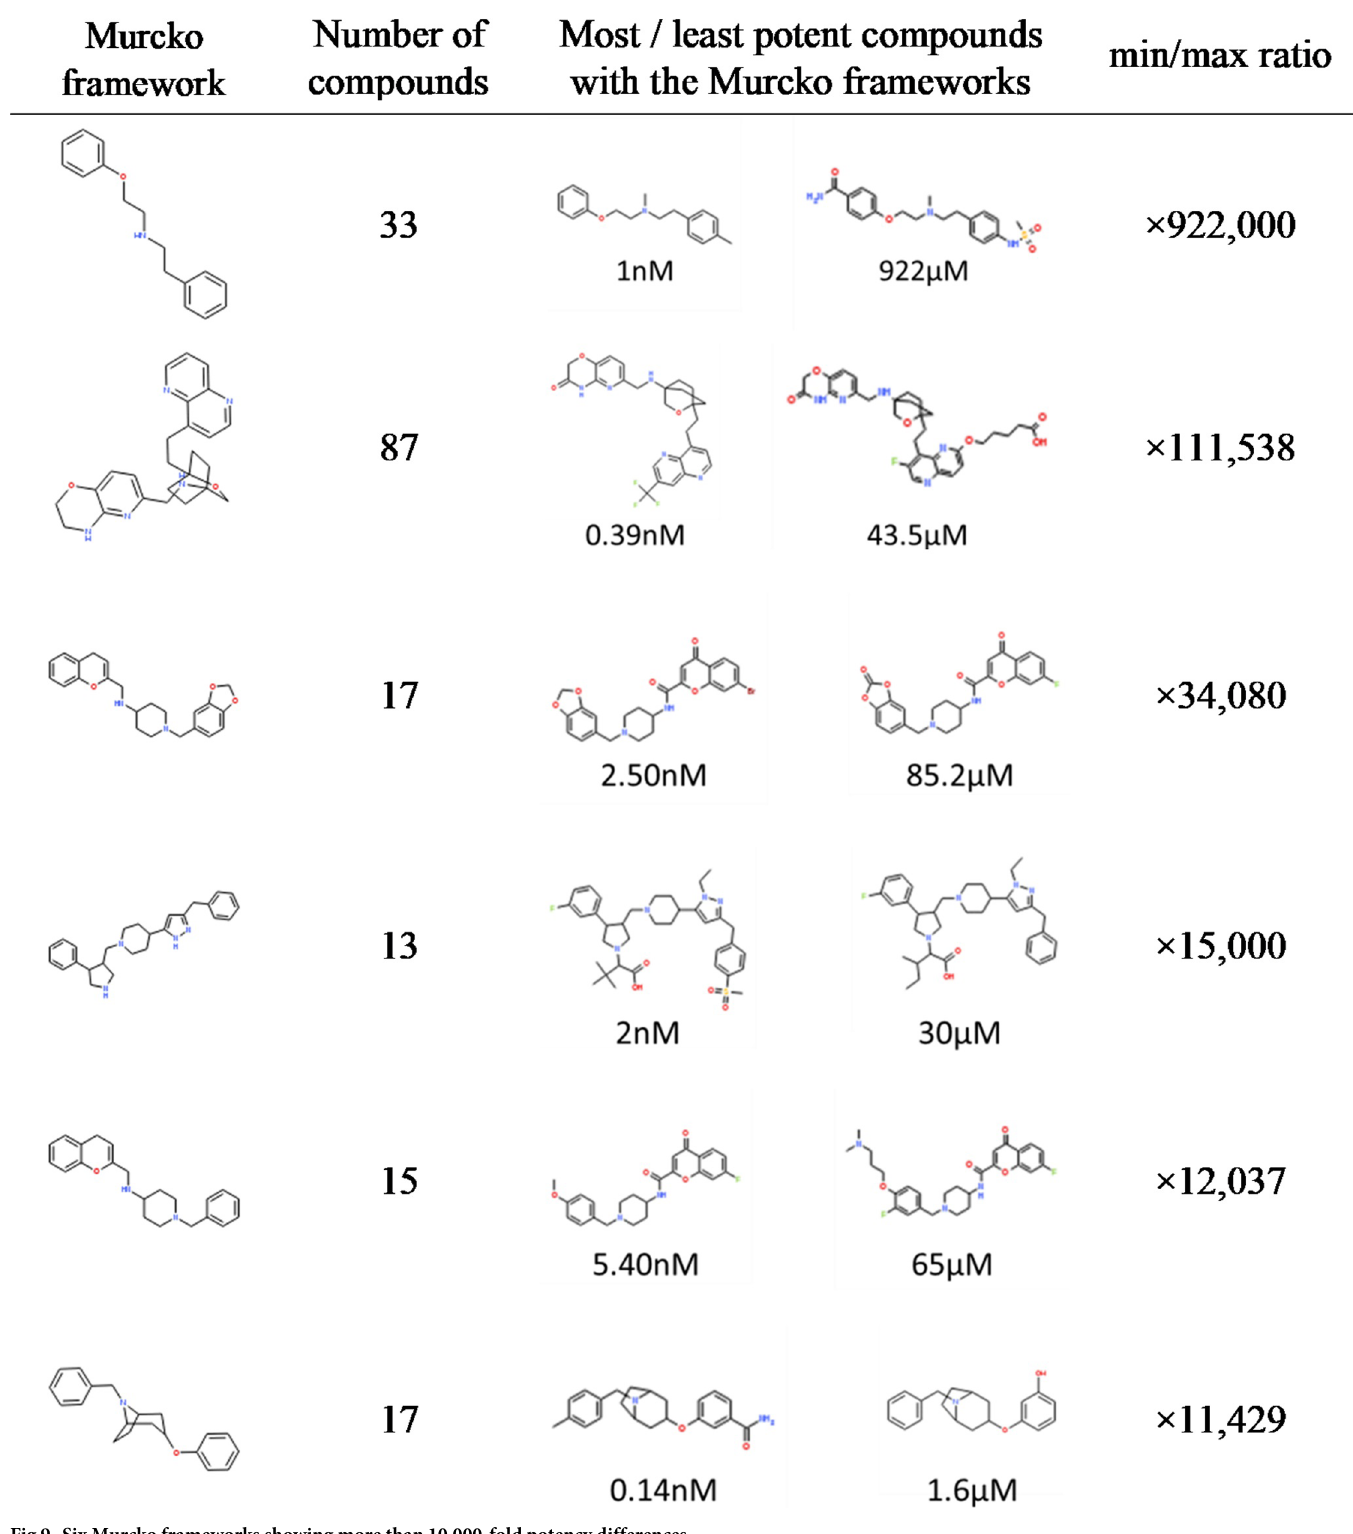
Fig 9. Six Murcko frameworks showing more than 10,000-fold potency differences.